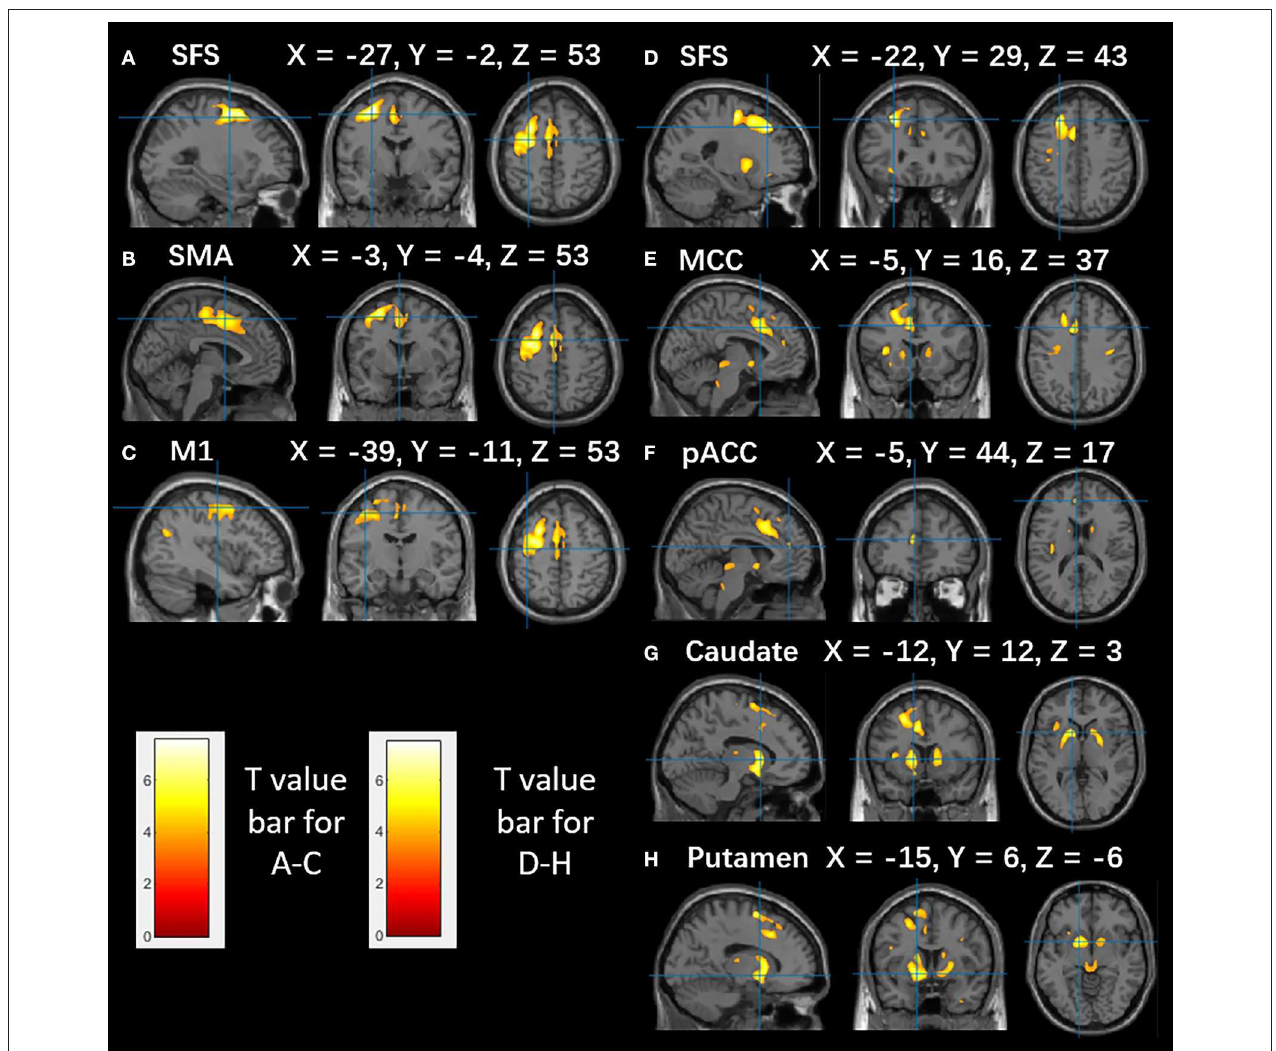
FIGURE 2 | The metabolism of SFS epilepsy patients compared to that of healthy controls. Brain areas with decreased glucose metabolism are superimposed on the MNI152 template ( P < 0.001). (A–C) Significant hypometabolism in the SFS, SMA, precentral gyrus in group 1. (D–H) Significant hypometabolism in the SFS, MCC, pACC, caudate, and putamen in group 2. The color scale indicates T scores. Note that PET images in patients with right-sided lesions are all horizontally flipped to the left